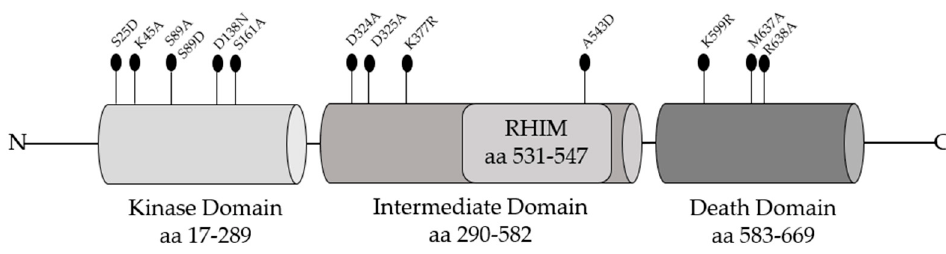
Figure 3. Aminoacidic substitutions in RIPK1 domains useful to elucidate its functional roles. While Ripk1 − / − mice shortly die after birth, mice with a RIPK1 inactive catalytic domain harboring the D138N mutation are protected from the shock induced by TNF treatment showing less hypothermia and mortality [36,50]. These results, already